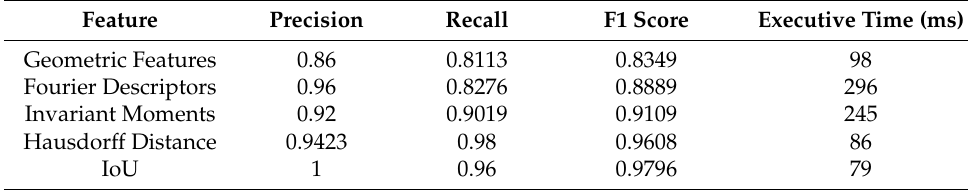
Table 10. Recognition rate and execution time with different